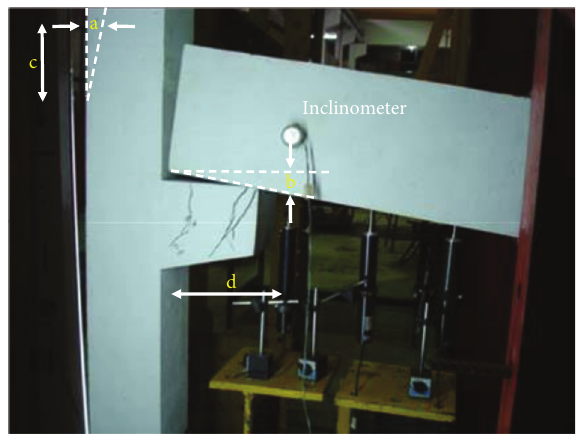
Figure 8: The installed inclinometer and measurement of the displacement of the beam and column [73].